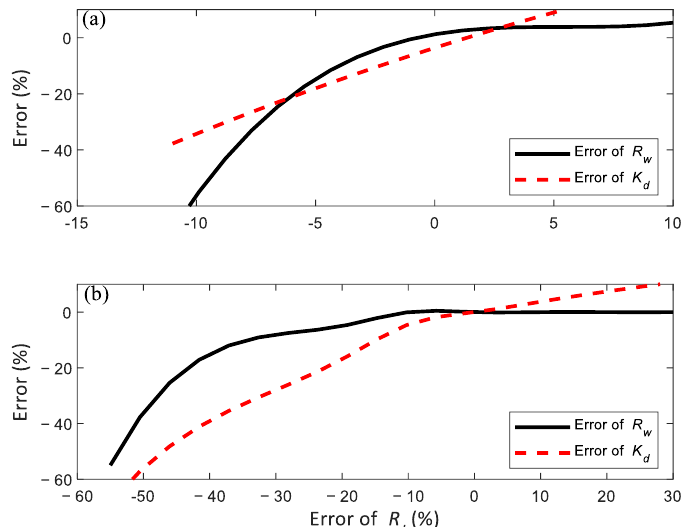
Remote Sens. 2022 , 14 , x FOR PEER REVIEW 22 of 24 Figure A2. The errors K d and R w estimated from synthetic tests (see text) averaged over water depths less than 2 m. To study the second assumption, we repeated this modelling to evaluate how poor knowledge of R b leads to errors in R w and K d within 2 m (a) and between 2 m and 6 m (b)